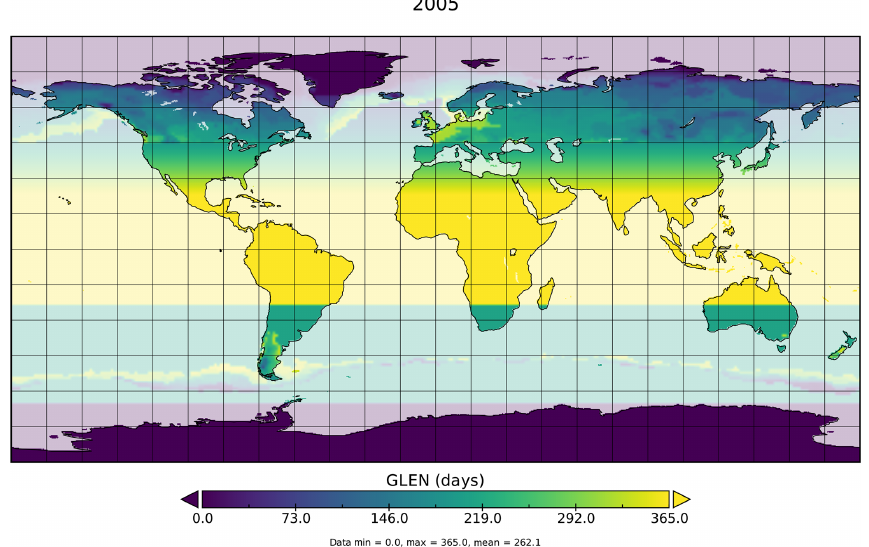
Figure 3. Pre-processing of greening season from meteorological surface temperature fields. Shown is the total length of the greening season (GLEN) for the year 2005. The 5 ◦ C day criteria have been used in both hemispheres’ mid–high latitudes. Ocean has been shaded to indicate that greening season will only affect